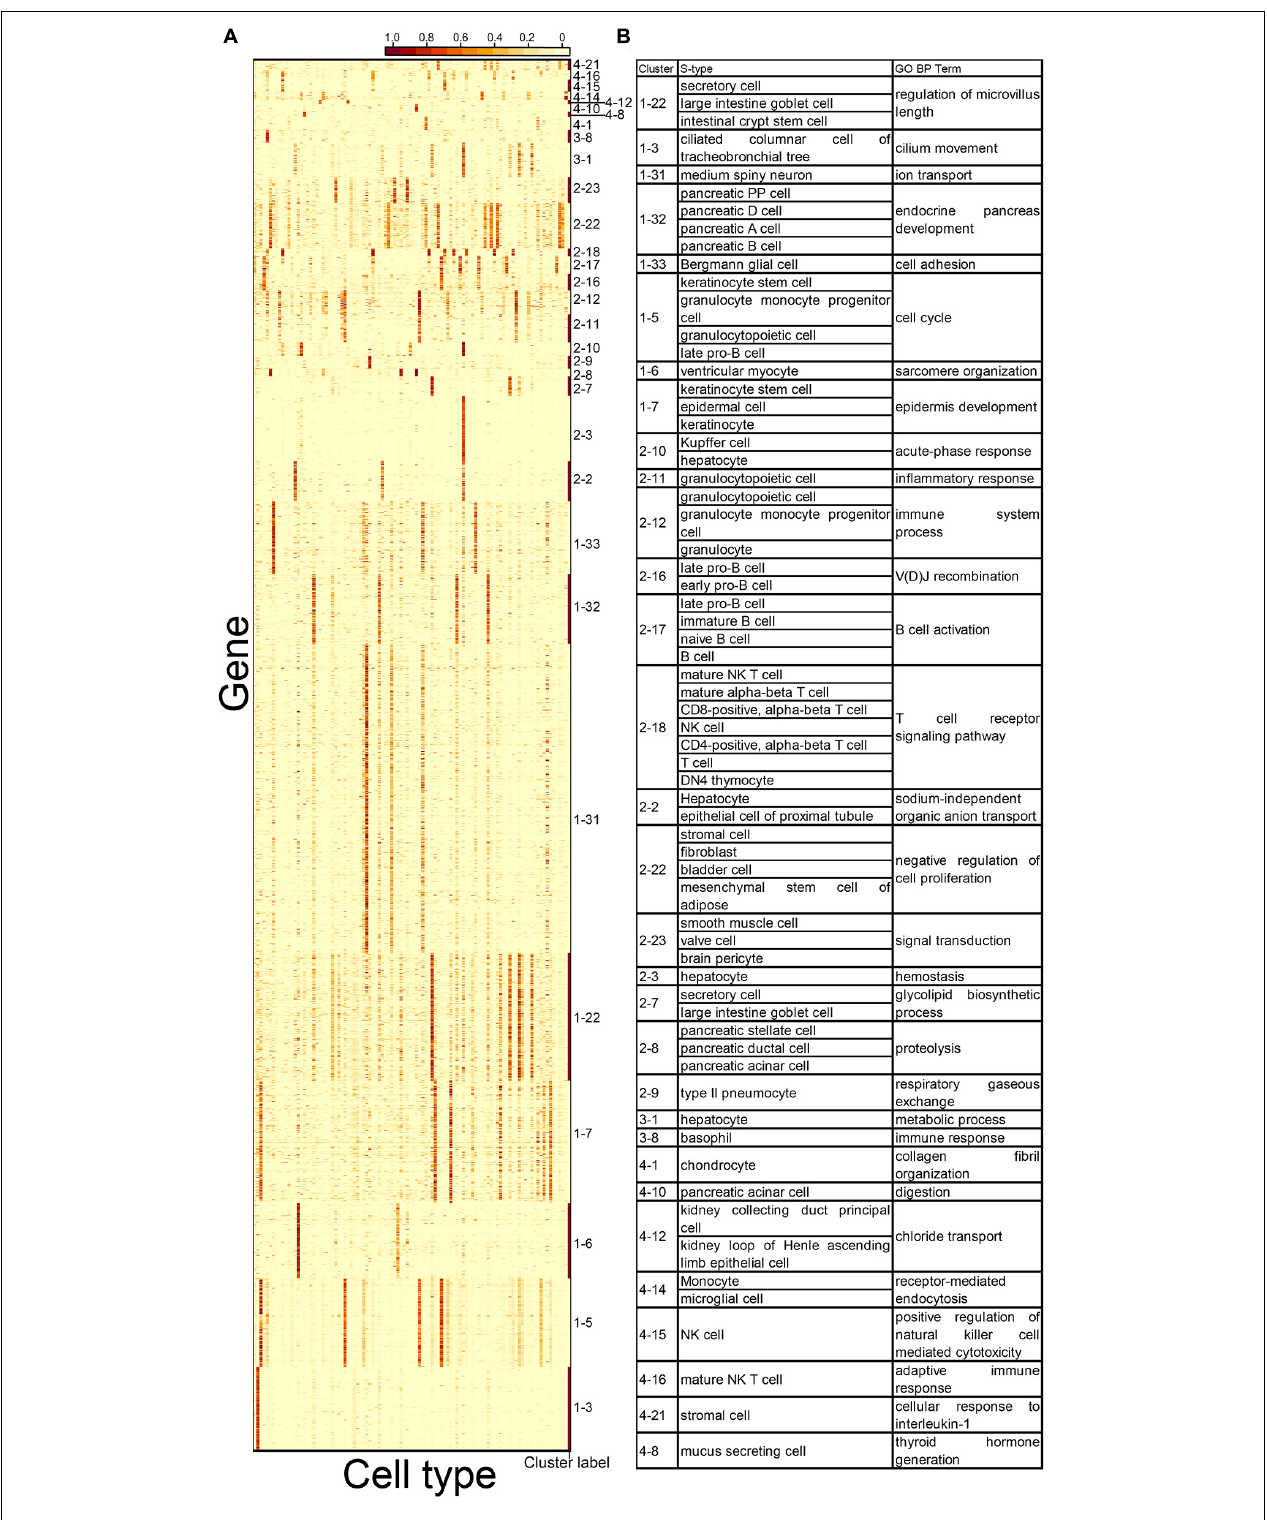
FIGURE 4 | Cell types and gene ontology (GO) terms associated with 31 CTS gene clusters. (A) Expression heatmap of 31 CTS gene clusters with enriched GO terms over the 101 cell types. Genes in the heatmap were sorted by the gene clusters, and the “cluster label” distinguished the genes from different gene clusters. The names of the 101 cell types are listed in Supplementary Table 1 (“Smart_3m” column) in the same order. (B) S types and selected GO terms of the 31 CTS gene clusters.